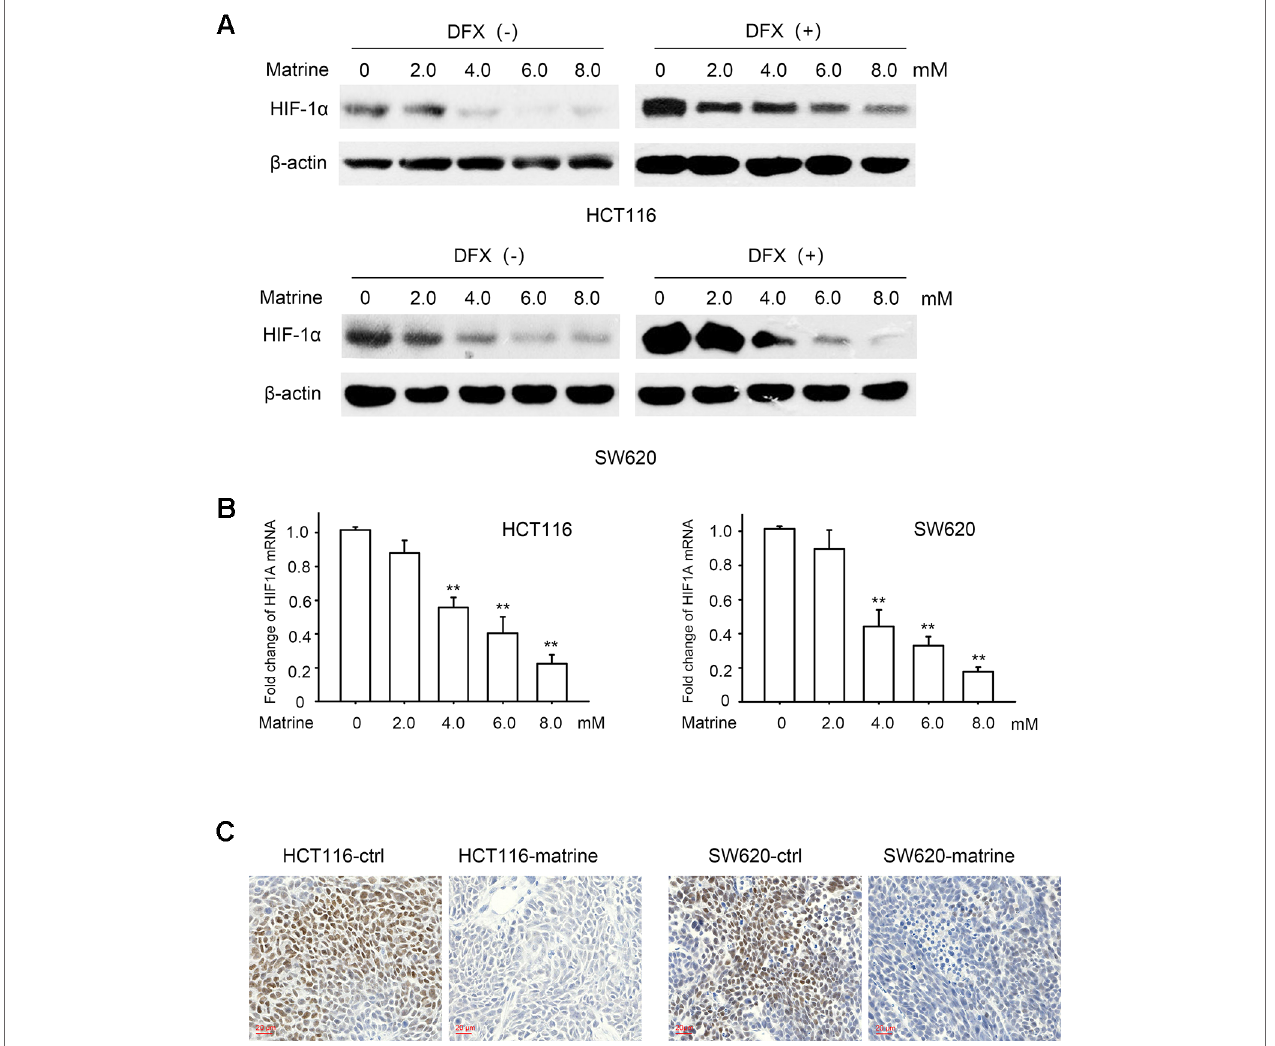
FIGURE 3 | Matrine suppressed messenger RNA (mRNA) transcription and protein expression of HIF-1α. (a) Western blotting shows the protein expression of HIF-1α in HCT116 and SW620 cells with 12 h treatment of 0~8.0 mM matrine together with or without 100 μM desferrioxamine treatment. (B) HIF-1α mRNA level as quantified by quantitative real-time-PCR in HCT116 and SW620 cells with the treatment of 0~8.0 mM matrine for 12 h. Data were expressed as mean ± SEM, n = 6. **, P < 0.01. (C) Immunohistochemistry showing the expression of HIF-1α in mouse xenograft tumors.